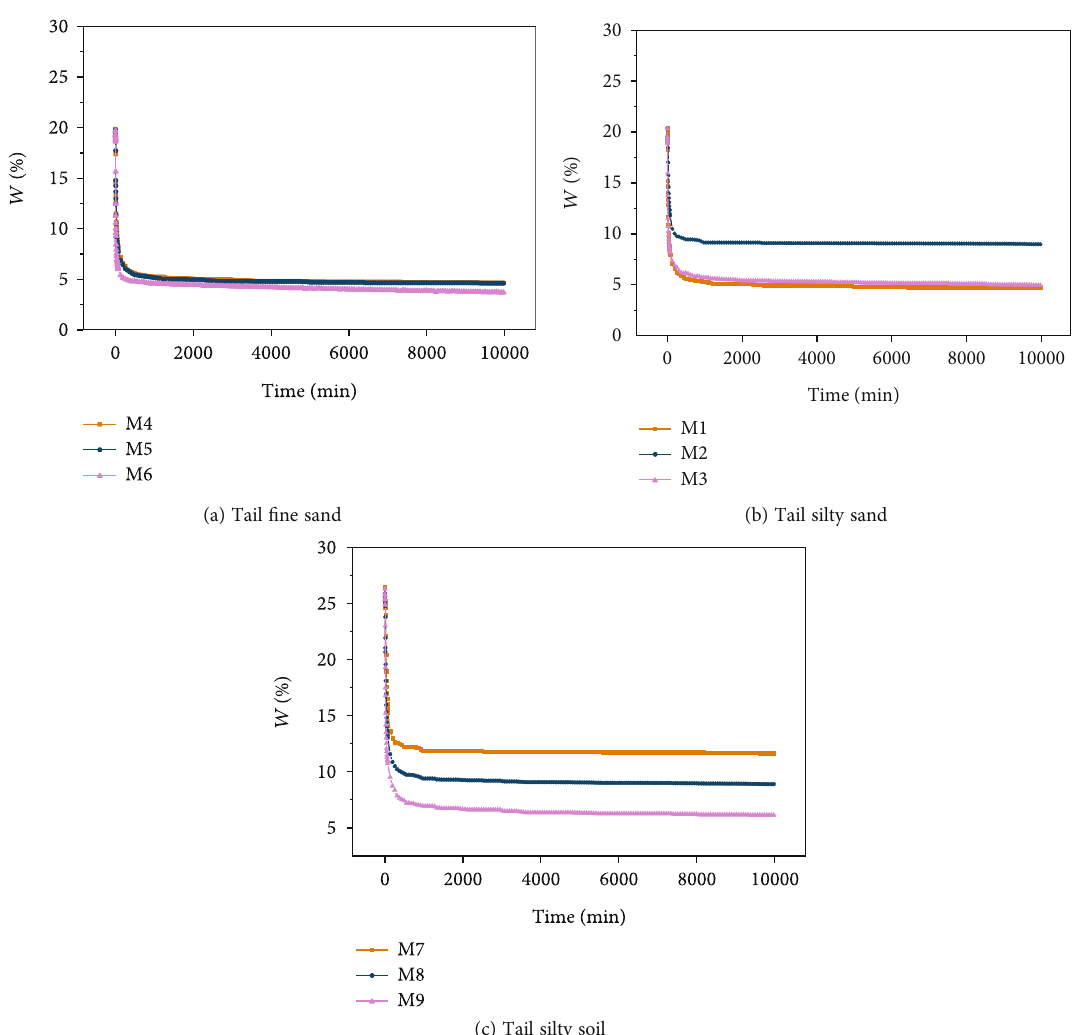
Figure 11: The moisture content change diagram of di ff erent sections in the water release